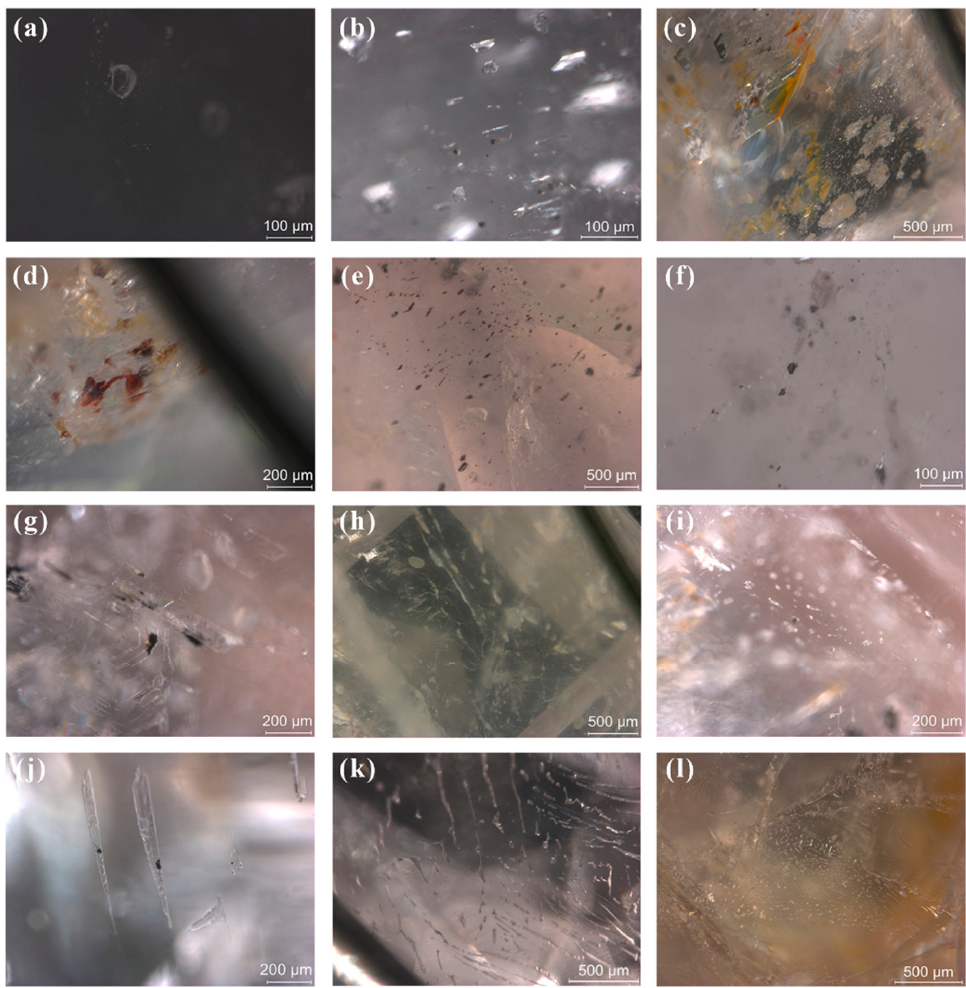
Figure 4. The inclusions in taaffeite samples. ( a , b ) irregular inclusions; ( c , d ) orange and brown intrusions; ( e , f ) black punctual and flake inclusions; ( g , h ) healed fissures; ( i , j ) multi-phase inclusions; ( k , l ) fingerprint-like inclusions (gas-liquid inclusions in healed fissures).